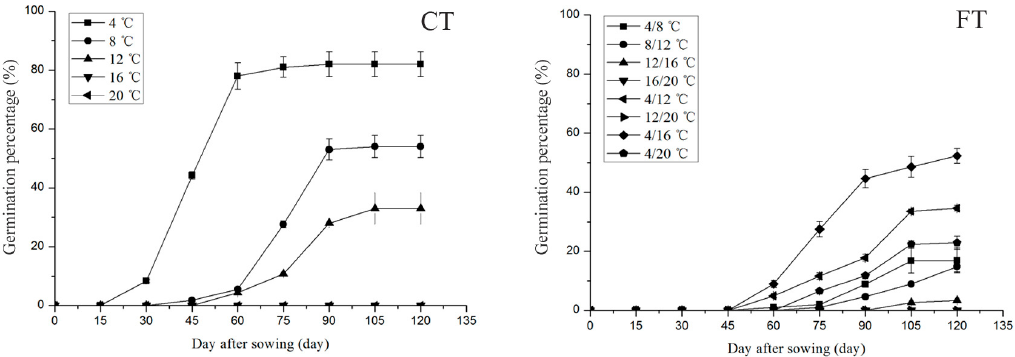
Figure 2. Effects of constant temperatures (CT) and fluctuating temperatures (FT) on the seed germination of Tulipa thianschanica. Different lowercase letters indicate a significant difference at p < 0.05 with Duncan’s multiple range test.